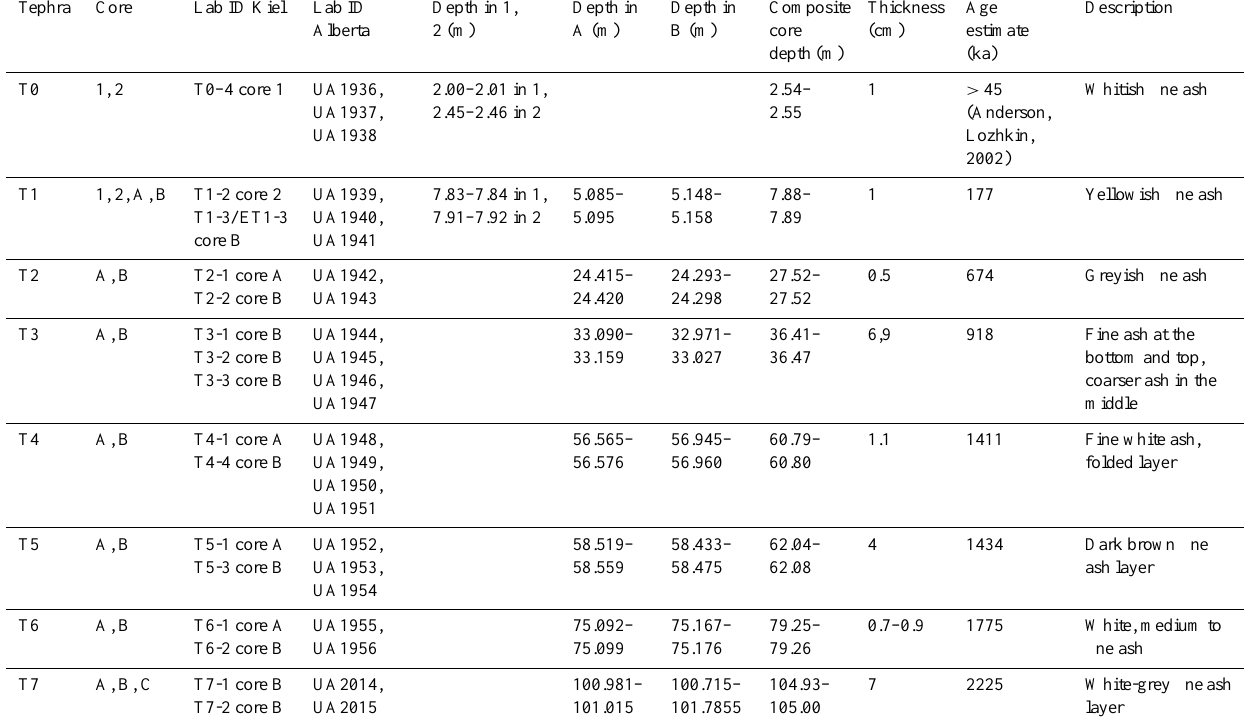
Table 1. Positions and ages of tephra layers identified in Lake El’gygytgyn sediments. Core abbreviations are as follows: 1 – PG1351; 2 – Lz1024; A – 5011-1A; B – 5011-1B; and C – 5011-1C. Core positions in Lake El’gygytgyn as in Melles et al. (2011). Age estimates and composite depth from Nowaczyk et al.